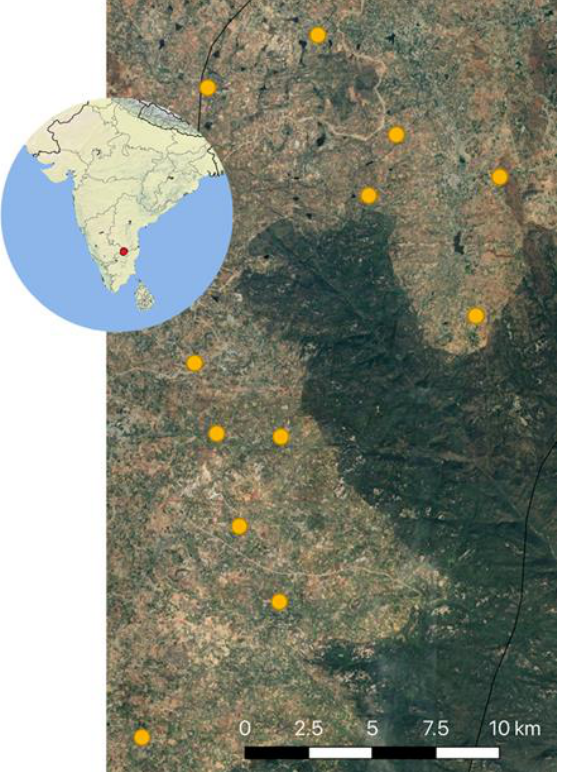
Figure 1. The location of chilli fields (yellow points). The study was conducted in the Chittoor district in the state of Andhra Pradesh,